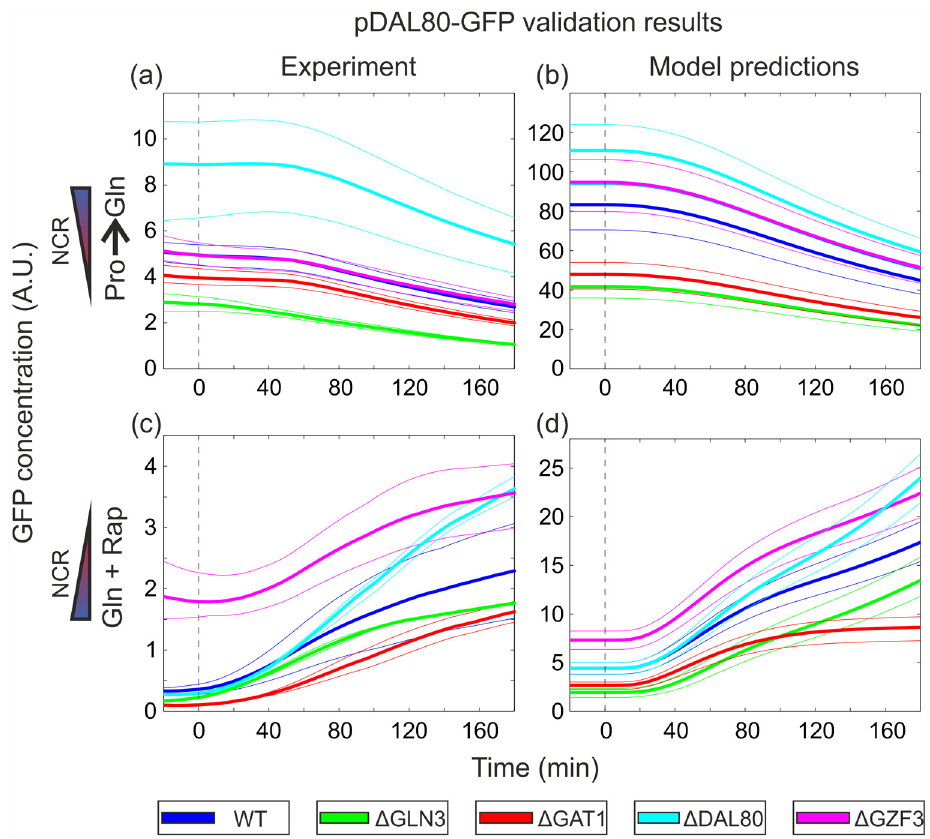
Fig 4. Data and model predictions for the yEGFP reporter driven by the DAL80 promoter (pDAL80-GFP). (a) Relative GFP concentrations for the Pro ! Gln shift. Upper and lower band limits: maximum and minimum experimentally observed values. Solid lines: mean of all biological replicates. (b) Model predictions of relative GFP concentrations for the Pro ! Gln shift, obtained from 100 randomly sampled posterior samples for the regulation function parameters. Upper and lower band limits: 80% and 20% quantiles. (c) Relative GFP concentrations for the Gln+Rap shift. Upper and lower band limits, solid lines: same as in (a). (d) Model predictions of relative GFP concentrations for the Gln+Rap shift. Prediction bands obtained as in (b). Note: the Y-axis scale units are arbitrary and different between the figures on the left and right